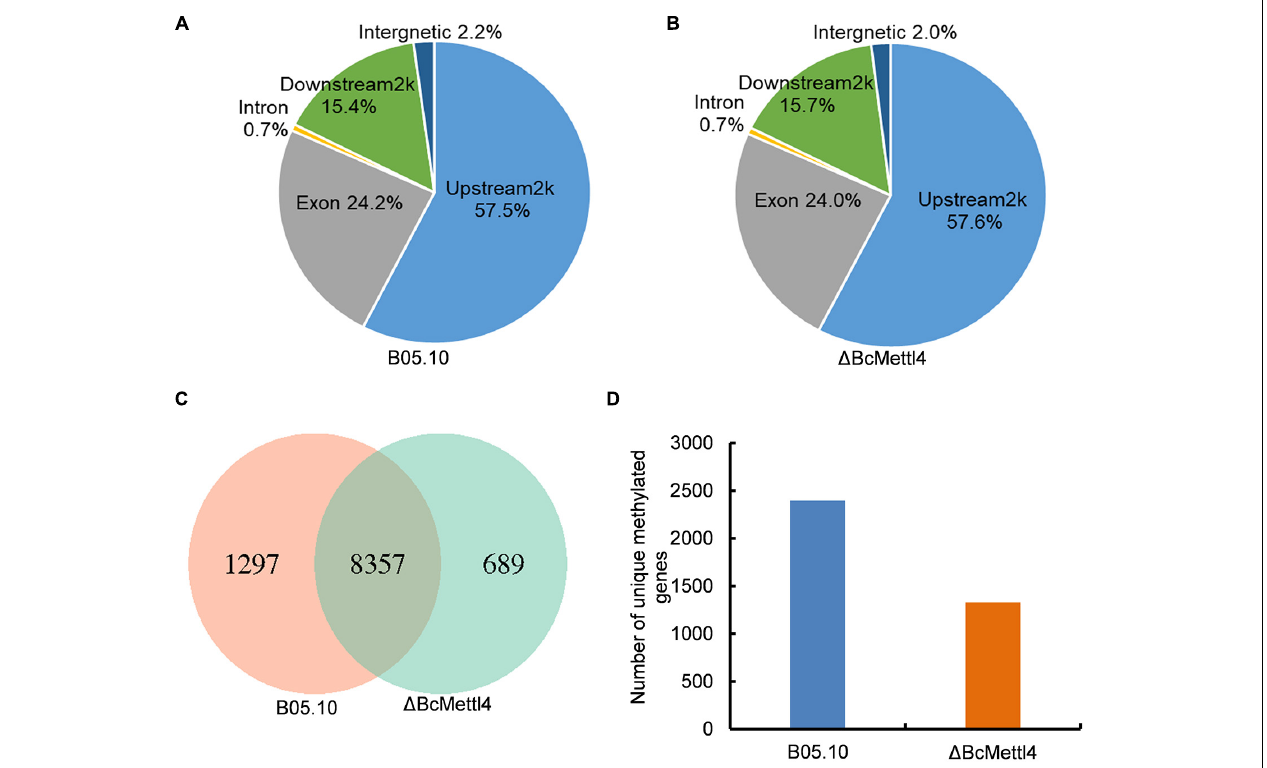
FIGURE 6 | The 6mA methylated genes in B. cinerea . (A) Peak distribution in genomic elements of the wild-type strain B05.10. (B) Peak distribution in genomic elements of the disruption mutant (cid:49) BcMettl4. (C) Venn diagram comparing unique 6mA peaks between the wild-type B05.10 and the mutant (cid:49) BcMettl4. (D) The number of unique methylated genes in wild-type strain B05.10 and the disruption mutant (cid:49)